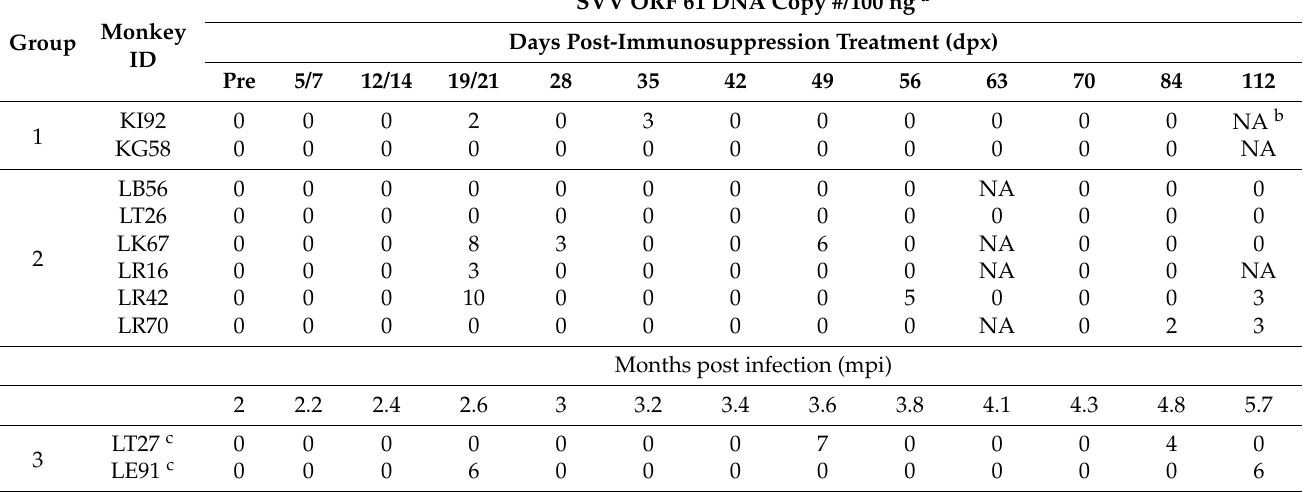
Table 4. Viremia during SVV